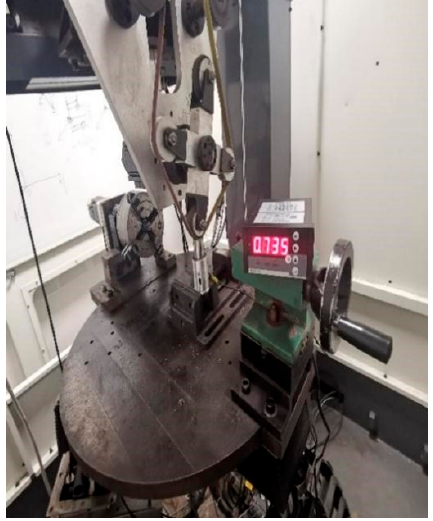
Figure 4. BSCC-H2 ZN4S integrator.